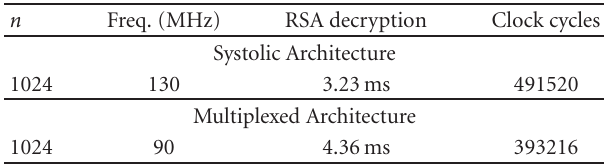
Table 2: RSA application (Virtex-5).